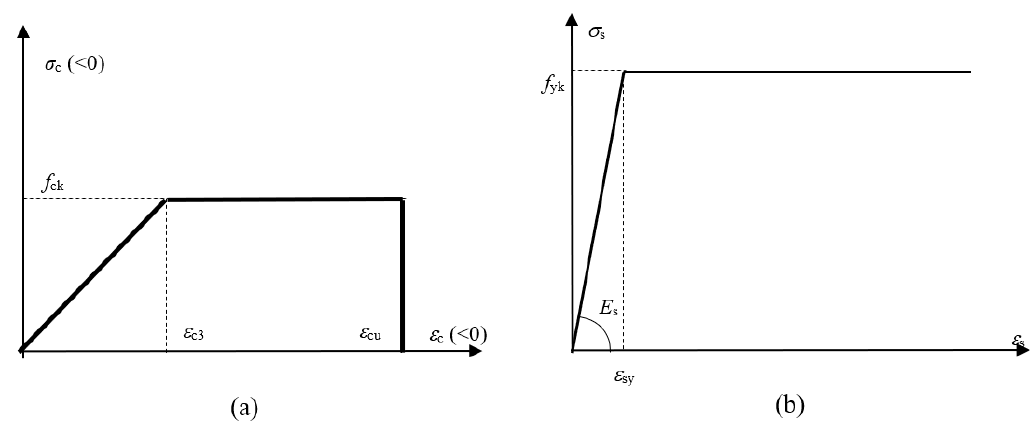
Figure 6. Materials constitutive law: ( a ) concrete, ( b ) steel. Table 2. Materials characteristics.